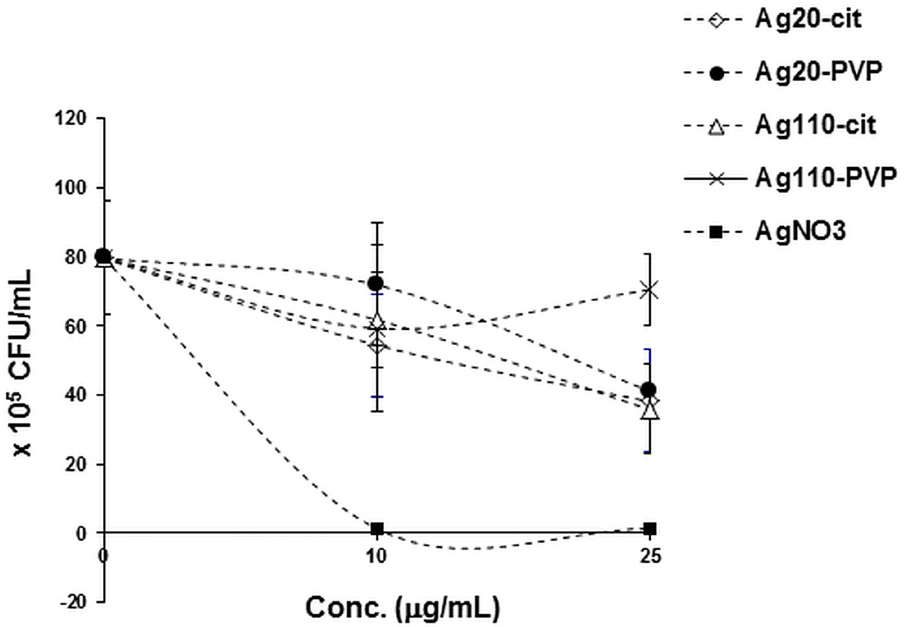
Fig 7. Effect of AgNP on the viability of M . tb . Ten μ l of M . tb stock suspension (10 7 CFU/mL) was diluted to 1 mL with cell culture media (RPMI1640 + 10% PHS, reflecting the environment in which AgNP and M . tb interacted with the MDM in vitro ) and incubated at 37°C on a rotating shaker in the presence of 0, 10 and 25 μ g/mL of AgNP and 15.7 and 39.25 μ g/mL of AgNO 3 . The amounts of AgNO 3 corresponded to the amount of Ag + ions present in 10 and 25 μ g/mL of AgNP, respectively. M . tb culture samples (10 μ L) were removed at 24 hours, diluted 10-fold by serial dilution, plated in triplicate onto 7H10 agar plates and incubated for 21 days at 37°C. CFU were determined as described in the Materials and Methods and plotted as a function of AgNP or Ag + ion concentration. Mean values from two independent experiments ± SD are